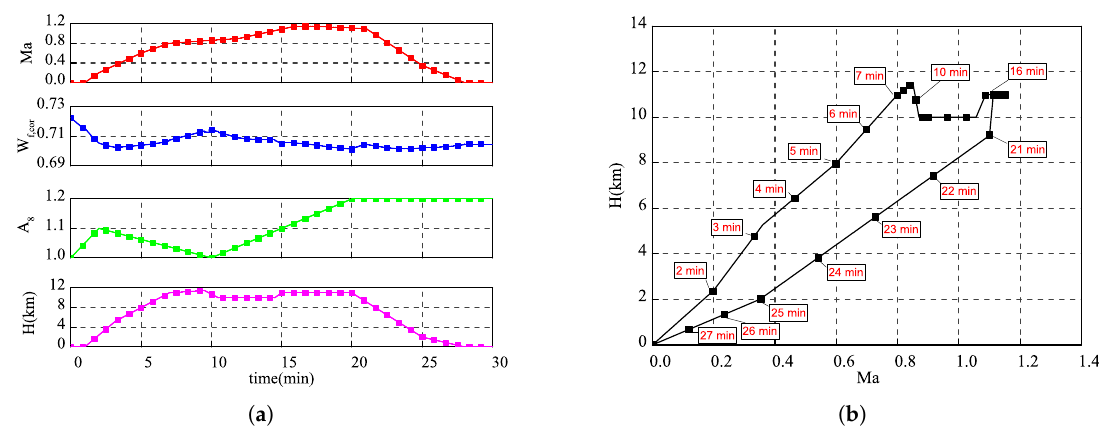
Figure 8. The inputs of the simulation: ( a ) 4 inputs without noise and ( b ) flight envelope. Table 1. maximum absolute error (MAE) and root mean square error (RMSE) (%). n